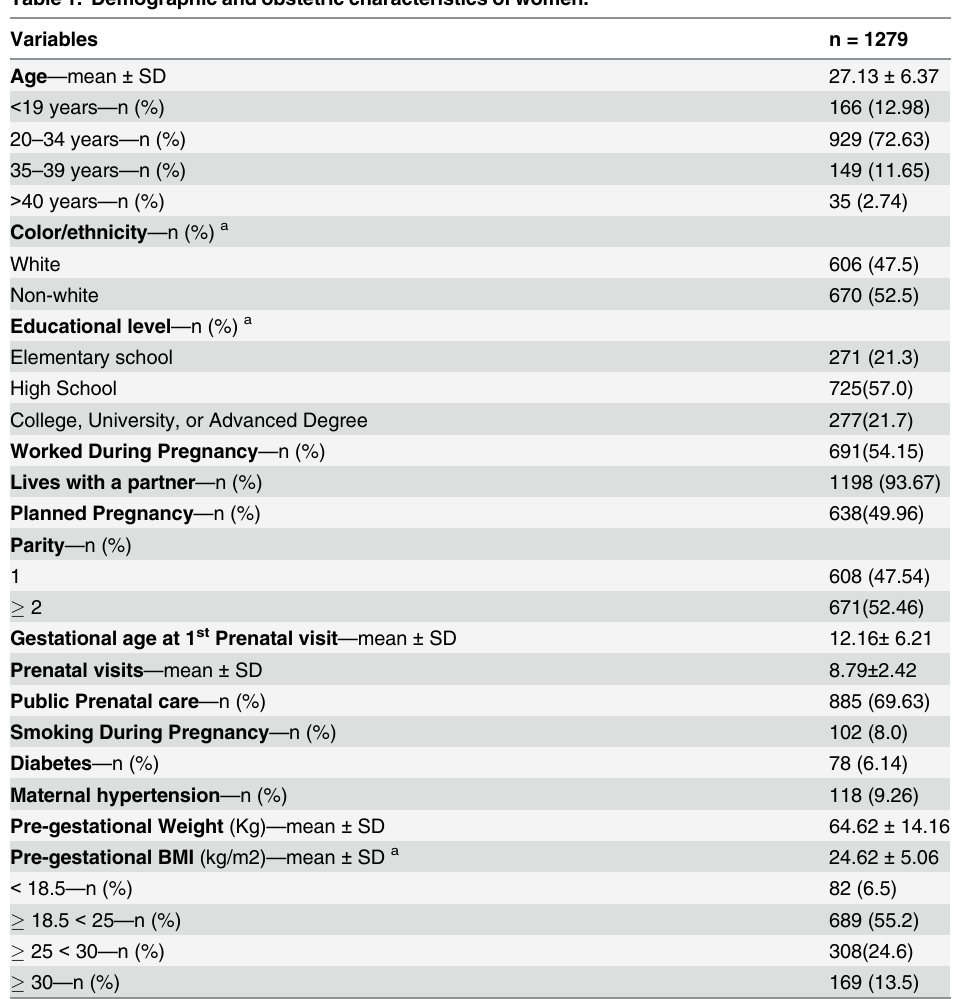
Table 1. Demographic and obstetric characteristics of